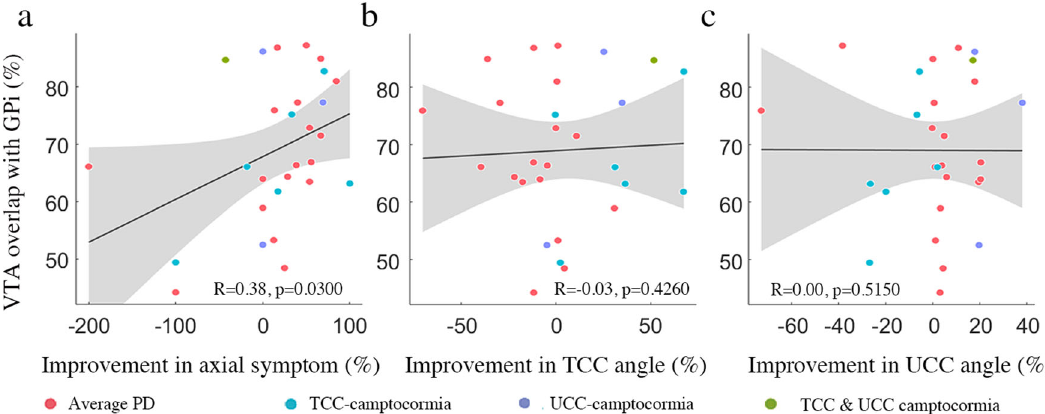
Fig. 5 Correlation between percentage of VTA overlap with GPi and outcomes. The overlap volume signi fi cantly correlated with improvements in subscores for axial symptoms ( a ), but not with improvements in TCC angles ( b ) and UCC angles ( c ). Gray areas represent the 95% CI. PD: Parkinson ’ s disease; VTA: volume of tissue activated; TCC: total camptocormia; UCC: upper camptocormia.